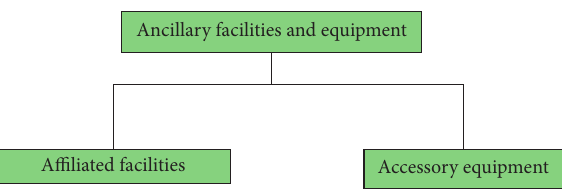
Figure 6: Risk hierarchy of ancillary facilities and equipment. Table 34: Ancillary facility risk judgment matrix.